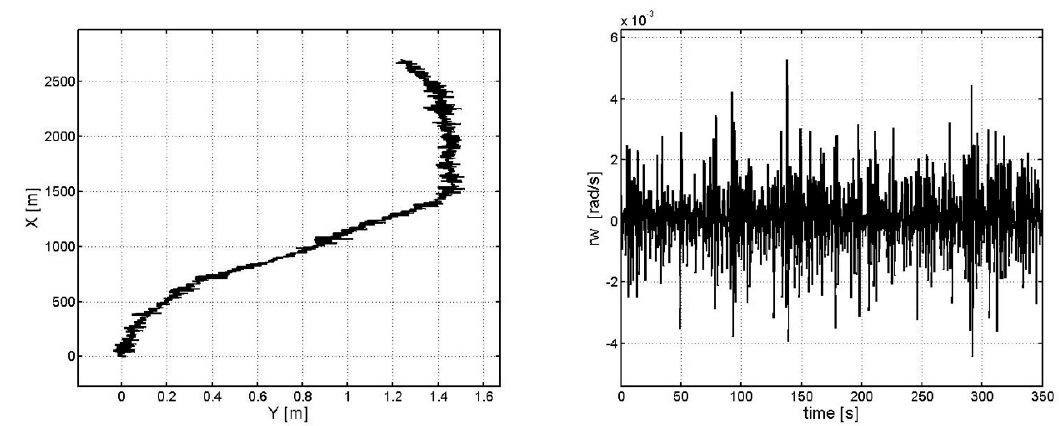
Figure 4. The trajectory of ship movement and signal of angular speed disturbance r w for sea state 4 and the wave angle −π /4.